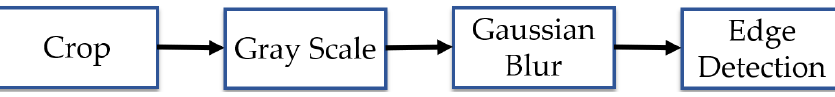
Figure 23. Flowchart of image processing.